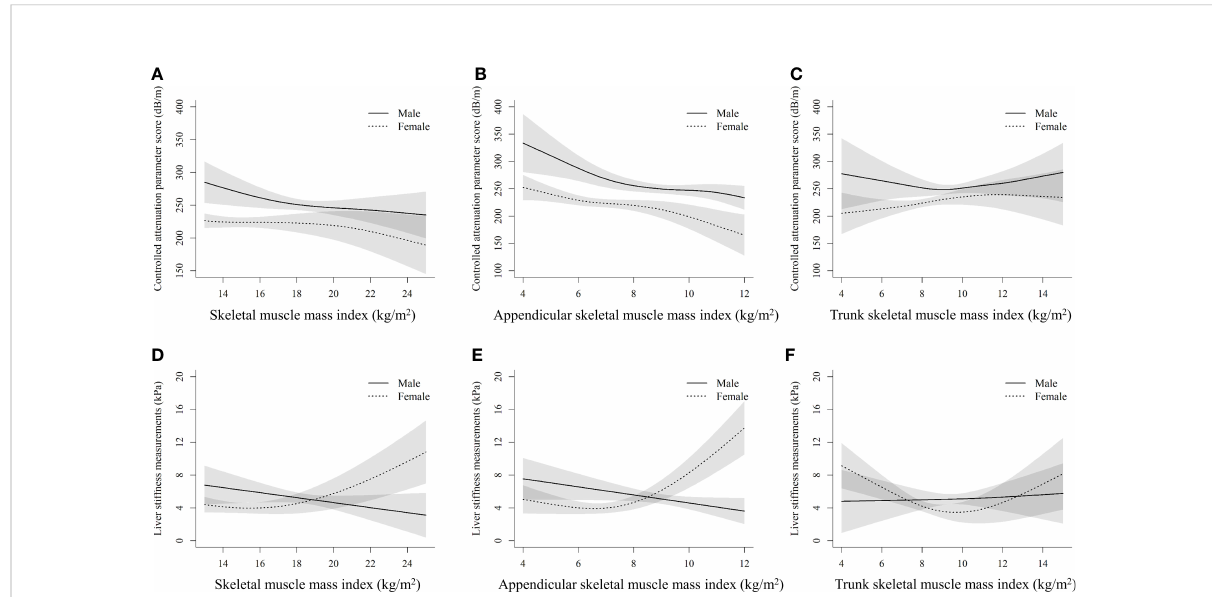
FIGURE 2 Nonlinear associations of muscle mass index with controlled attenuation parameter score and liver stiffness measurements by sexes (A) , (B) , and (C) stand for the whole-body skeletal muscle mass index, appendicular skeletal muscle mass index, and trunk skeletal muscle mass index with controlled attenuation parameter score, respectively. (D) , (E) , and (F) stand for the whole-body skeletal muscle mass index, appendicular skeletal muscle mass index, and trunk skeletal muscle mass index with liver stiffness measurements, respectively. The models are adjusted for age, race, education, poverty, married status, smoking, alcohol use, health eating index, physical activity, BMI, hypertension, waist circumference, total cholesterol, alanine aminotransferase, aspartate transaminase, and fat mass